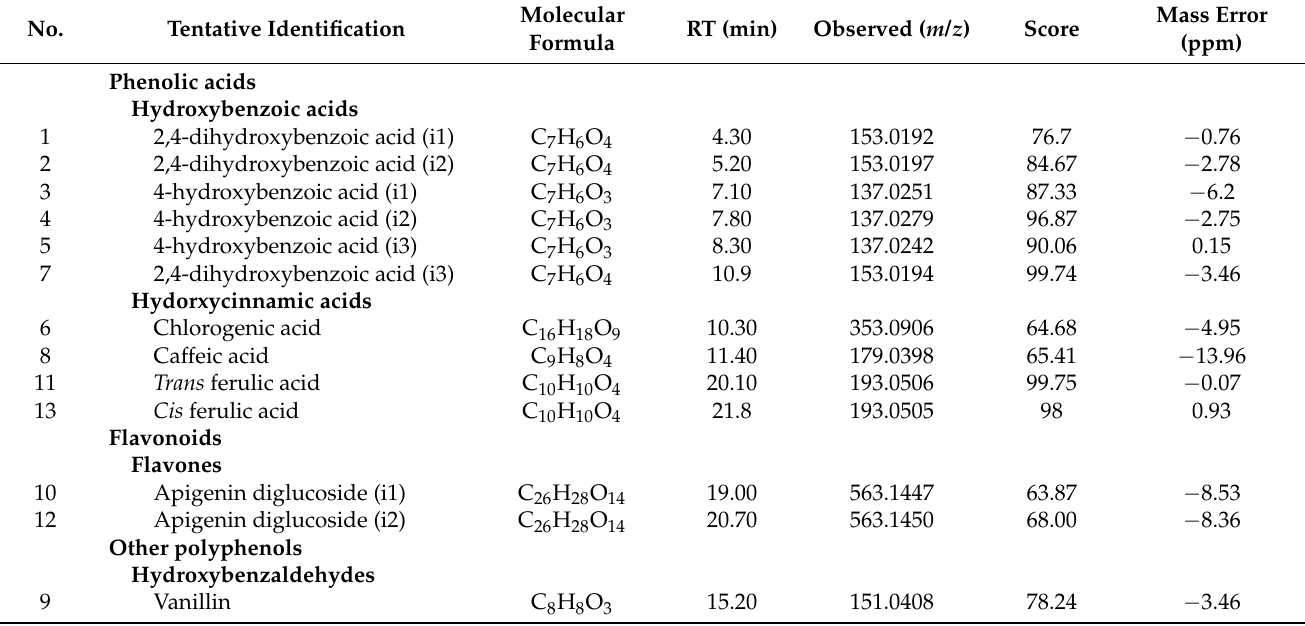
Table 2. Chromatographic and mass spectrum data of the phenolic compounds identified in spray-dried (SPD) WB hydrolysates.